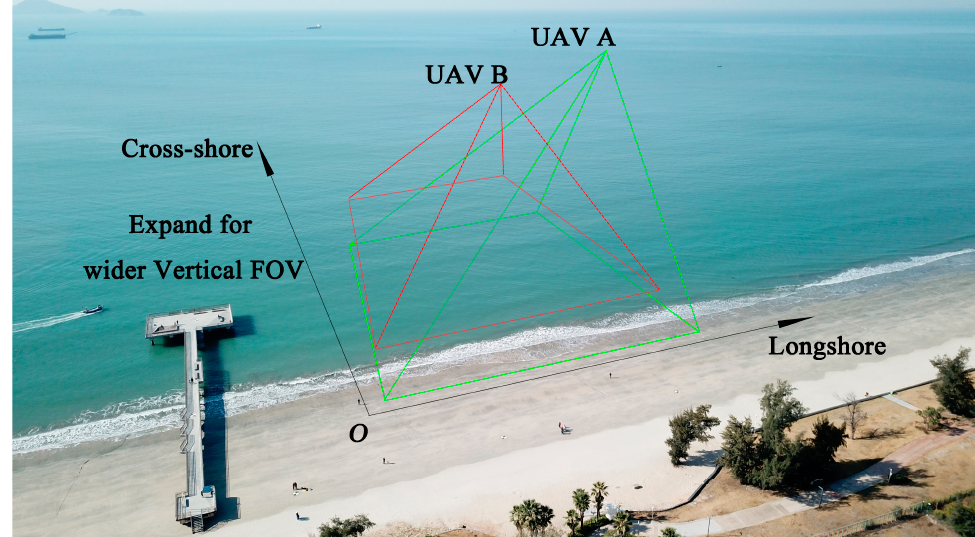
Figure 24. Two UAVs were placed to capture distant cross-shore.